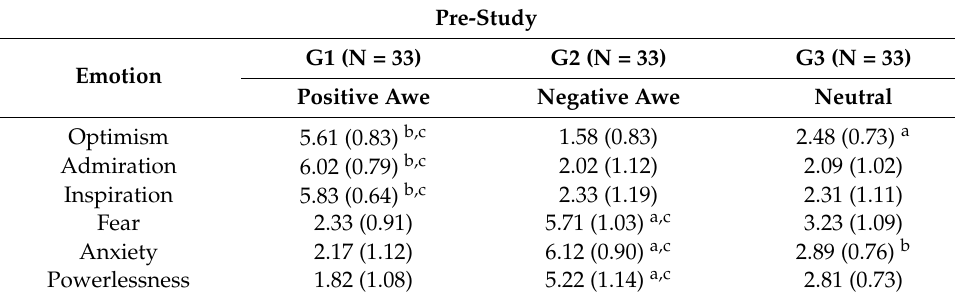
Table 1. Mean scores for self-reported emotional states in Pre-study.